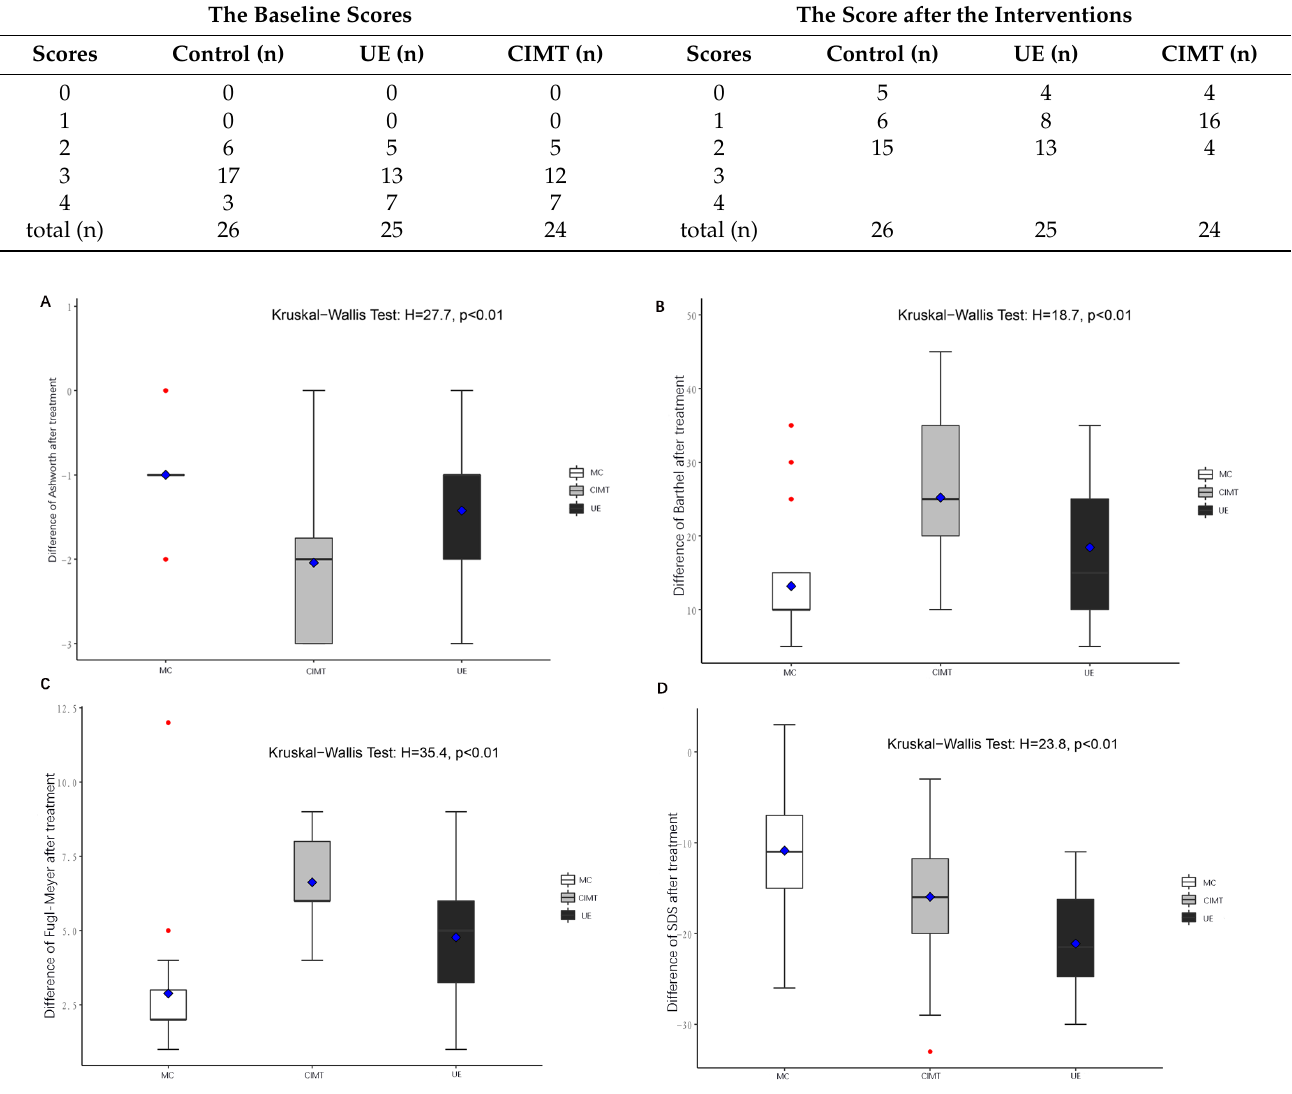
Table 4. The scores of Ashworth.